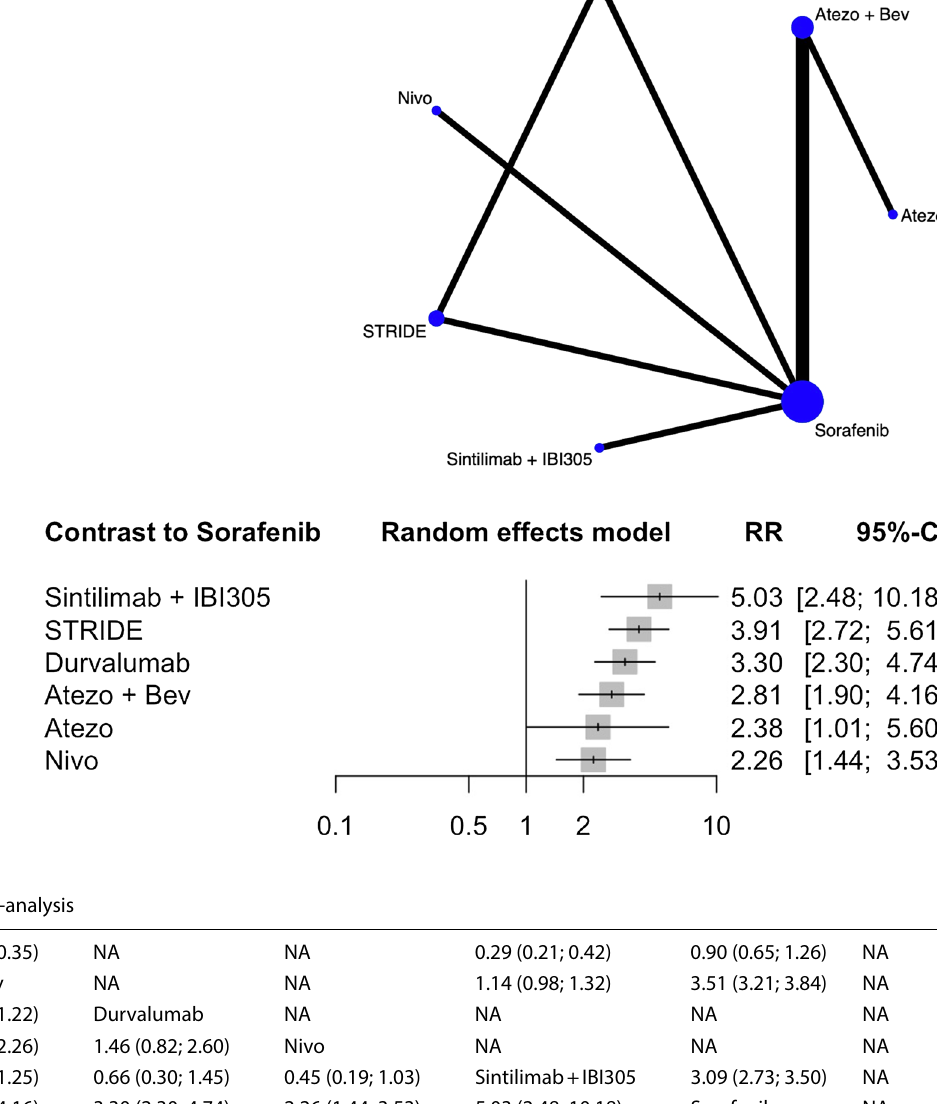
Fig. 8 Network plot of ORR